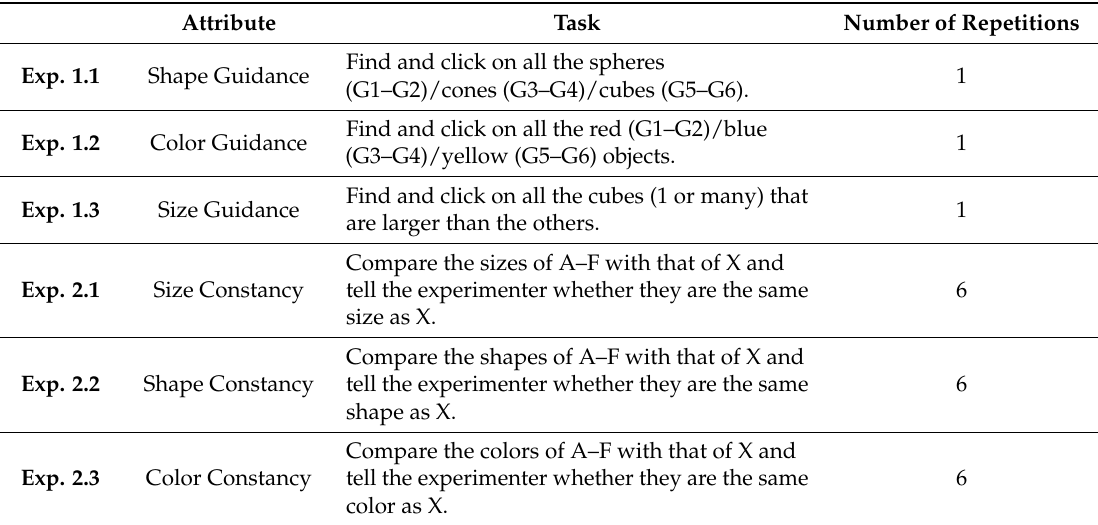
Table 1. Experimental